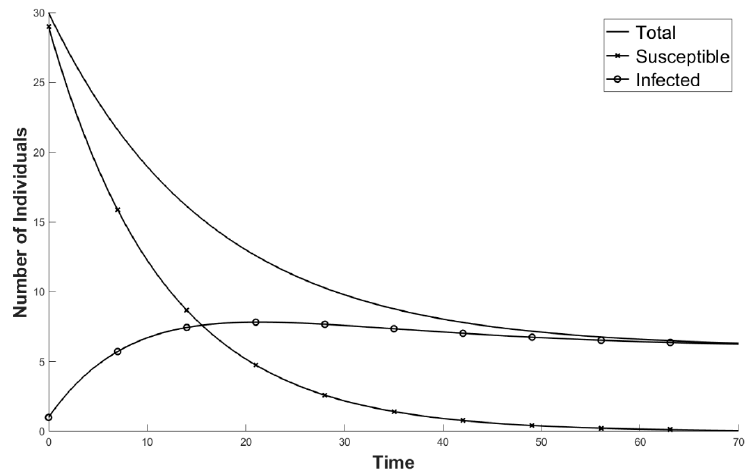
Figure 6. Illustration of the predicted dynamics of a common frog population, with the ranavirus factoring in an annual population decline of 8.1% for adult common frogs. ( Ψ = 0.45; σ = 0.3; M N = 0.2; M D = 0.775; starting population comprised of A I = 1 and A S = 29; time is in years.) A s is the number of susceptible individuals, Ψ is the contact rate, σ is the likelihood of transmission, M N is the natural mortality rate, and M D is the mortality rate associated with the ranavirosis.